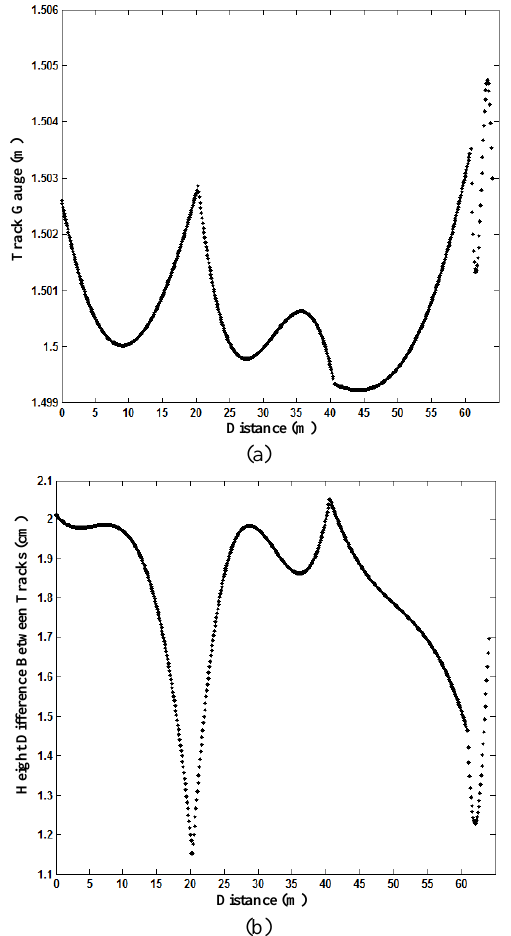
Figure 8: Geometric information of tracks derived from 3D track models reconstructed: (a) variation of track gauge and (b) variation of height difference of a pair of single